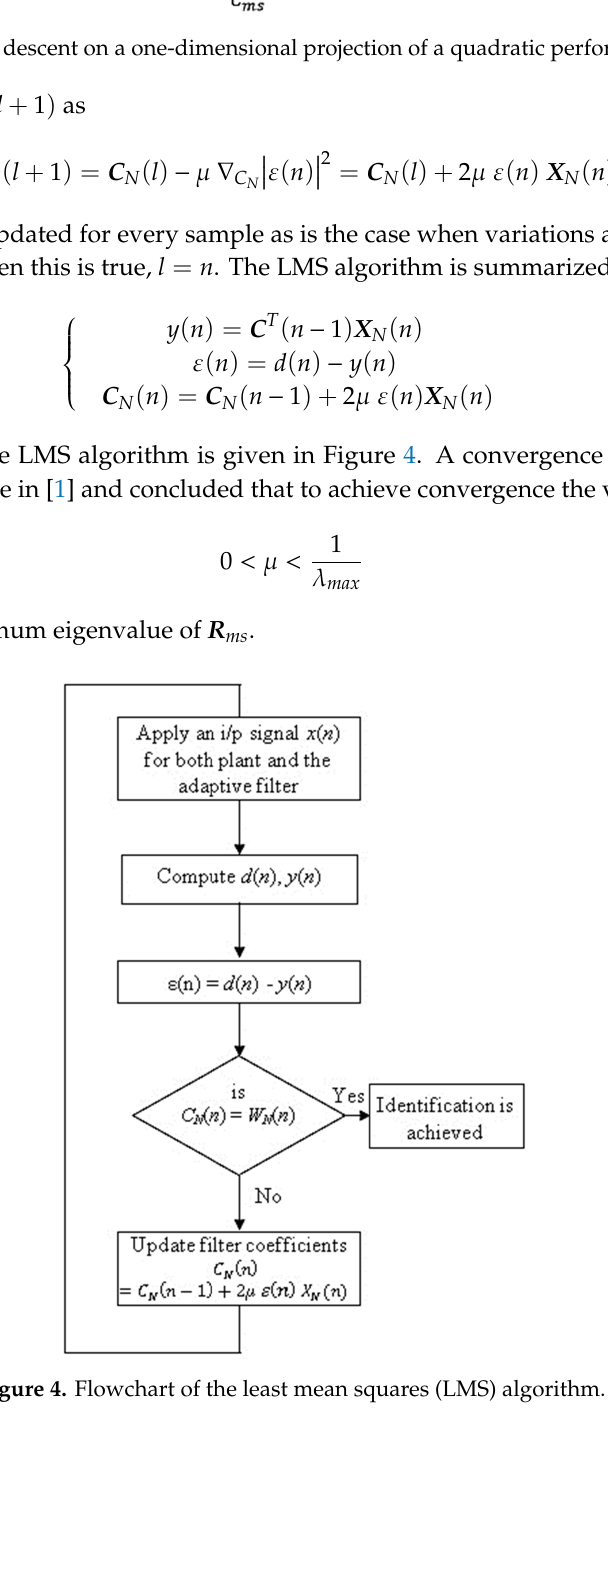
Figure 4. Flowchart of the least mean squares (LMS) algorithm.